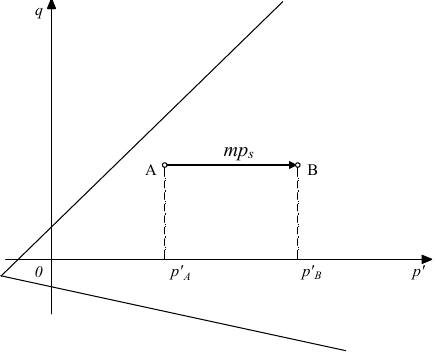
Figure 4. Strength surface in p ′ - q space.